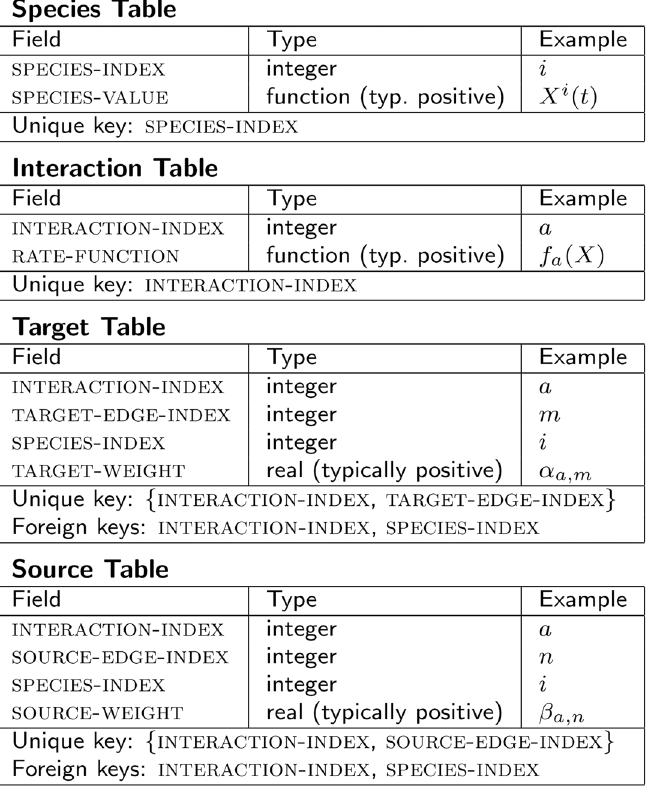
Fig 2. Database representation of an OFFL model. The four tables which represent OFFL diagrams as a relational database. The “ Example ” columns refer to quantities as they appear in Eq (3).